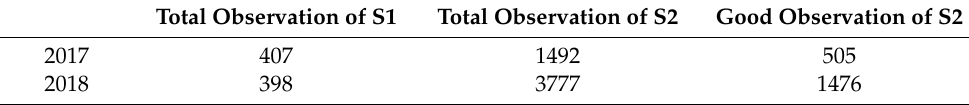
Table 1. Number of Sentinel-1 and Sentinel-2 imagery used in this study. Total Observation of